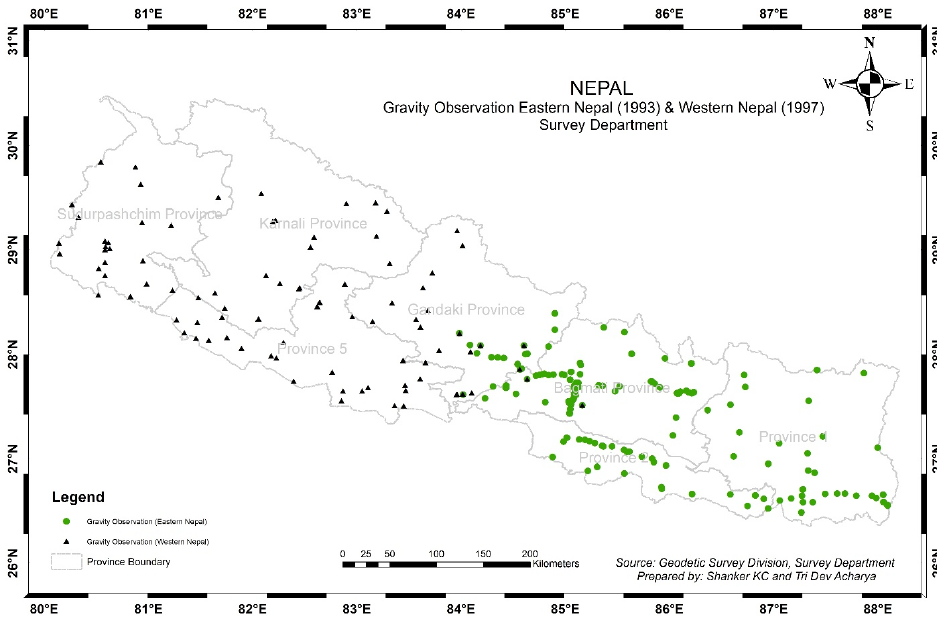
Figure 13. Gravity survey by east and west topographic mapping project (1993–1997) [43,48]. 4. Gravity Survey in 1997 by WNTMP and NEPAL97 Geoid Within the project WNTMP, gravity observations were performed in several GPS stations using a Worden gravimeter. The distribution of gravity stations is as shown in Figure 13. The Finnish Geodetic Institute (FGI) developed the gravimetric geoid of Nepal using a combination of new gravity observations, gravity data from ENTMP, GPS- leveling differences, and EGM96. Geoid thus developed called NEPAL97 and has an accuracy of ±1 m [48]. This geoid is then used to provide heights above MSL published in topographic maps by WNTMP. Figure 14 shows the geoidal contour of Geoid NEPAL97 computed during WNTMP by Finnish Geodetic Institute .